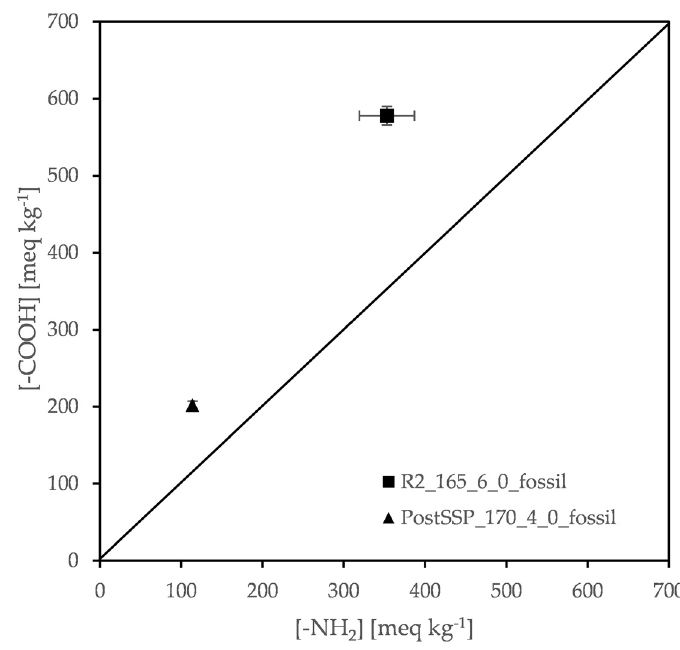
Figure 12. The two-step DSSP process: amine and carboxyl end group concentration of one-step and two-step DSSP products.